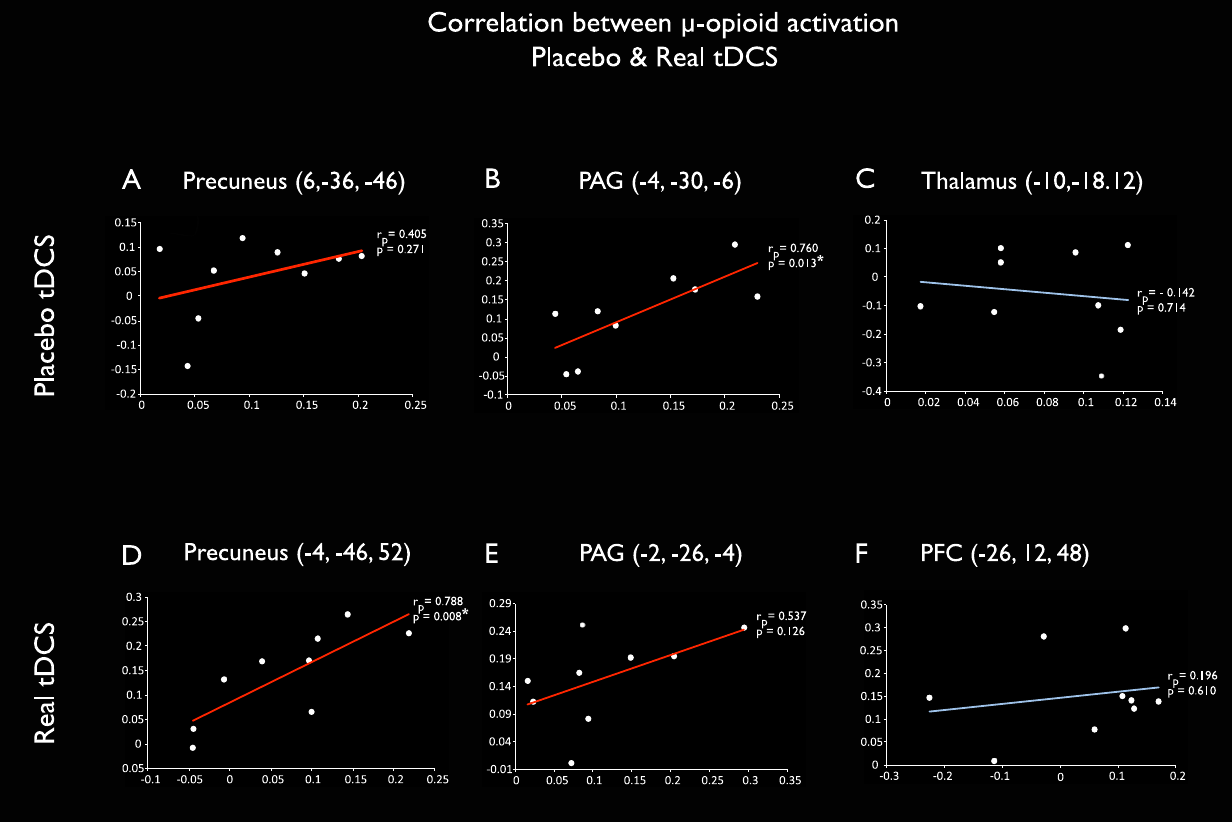
Figure 3. Correlation between placebo and real tDCS-induced MOR activation. MOR BP ND during placebo (x axis) and real (y axis) tDCS for each subject in the clusters of m -opioid activation induced by placebo (A–C) and real (D–F) tDCS. The same clusters are illustrated in the figure 2. Positive correlations can be observed in precuneus and PAG (red lines) but not in thalamus and PFC (blue lines). Statistically significant values at p , 0.05 were found in the PAG cluster activated during placebo tDCS (r p =0.760, p=0.013, 3B) and in the precuneus cluster activated during active tDCS (r p =0.788, p=0.008, 3D).